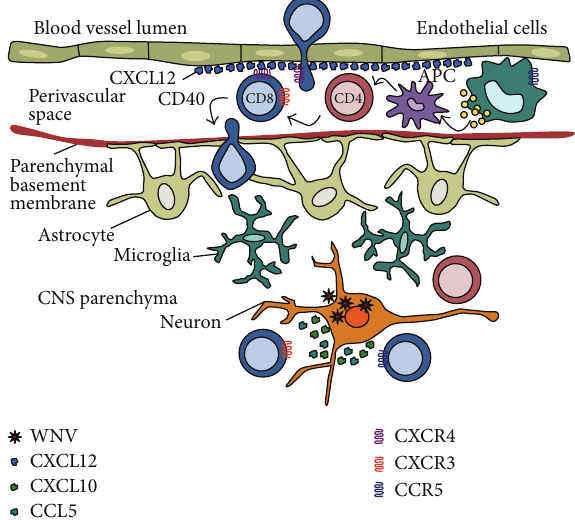
Figure 2: Neuroprotective roles of chemokines in response to viral infection of the CNS. Functional roles of chemokines in attracting and activating lymphocytes into the CNS during acute viral infection. Monocytes are attracted into the CNS via the chemokine CCL5 and its receptor CCR5. Macrophages produce IL-1 𝛽 within the CNS and ensure full activation and CXCL12- mediated interactions of infiltrating leukocytes. CXCR4-expressing lymphocytes are captured by endothelial expression of CXCL12 within the perivascular spaces, which promotes CD4 + T-cell help to infiltrate CD8 + T lymphocytes. In addition to full activation, lymphocyte egress from perivascular spaces requires CD40. During the acute stage of disease, virally infected neurons secrete CXCL10 and CCL5 that attract activated T lymphocytes bearing the receptor CXCR3 and/or CCR5 into the parenchyma. CD8 + and CD4 + T lymphocytes mediate viral control through direct cytolytic activity and/or cytokine